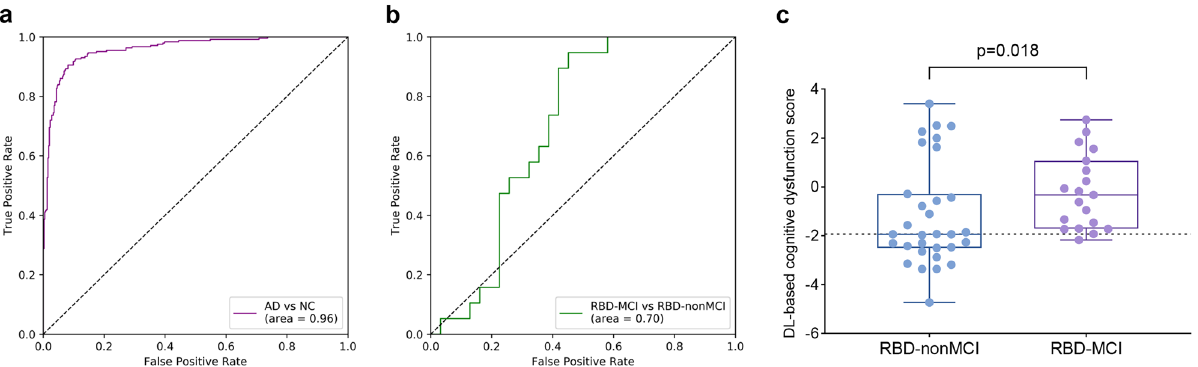
Figure 1. Deep learning-based cognitive signature of [ 18 F]FDG PET for differentiating RBD-MCI from RBD-nonMCI. ( a ) The AUC of ROC curves for differentiating AD from NCs in ADNI cohort was 0.96 (95% CI 0.94–0.97). ( b ) The AUC of ROC curves for differentiating RBD-MCI from RBD-nonMCI was 0.70 (95% CI 0.56–0.82). ( c ) DL-based cognitive dysfunction score was significantly higher in RBD-MCI than in RBD- nonMCI ( P =